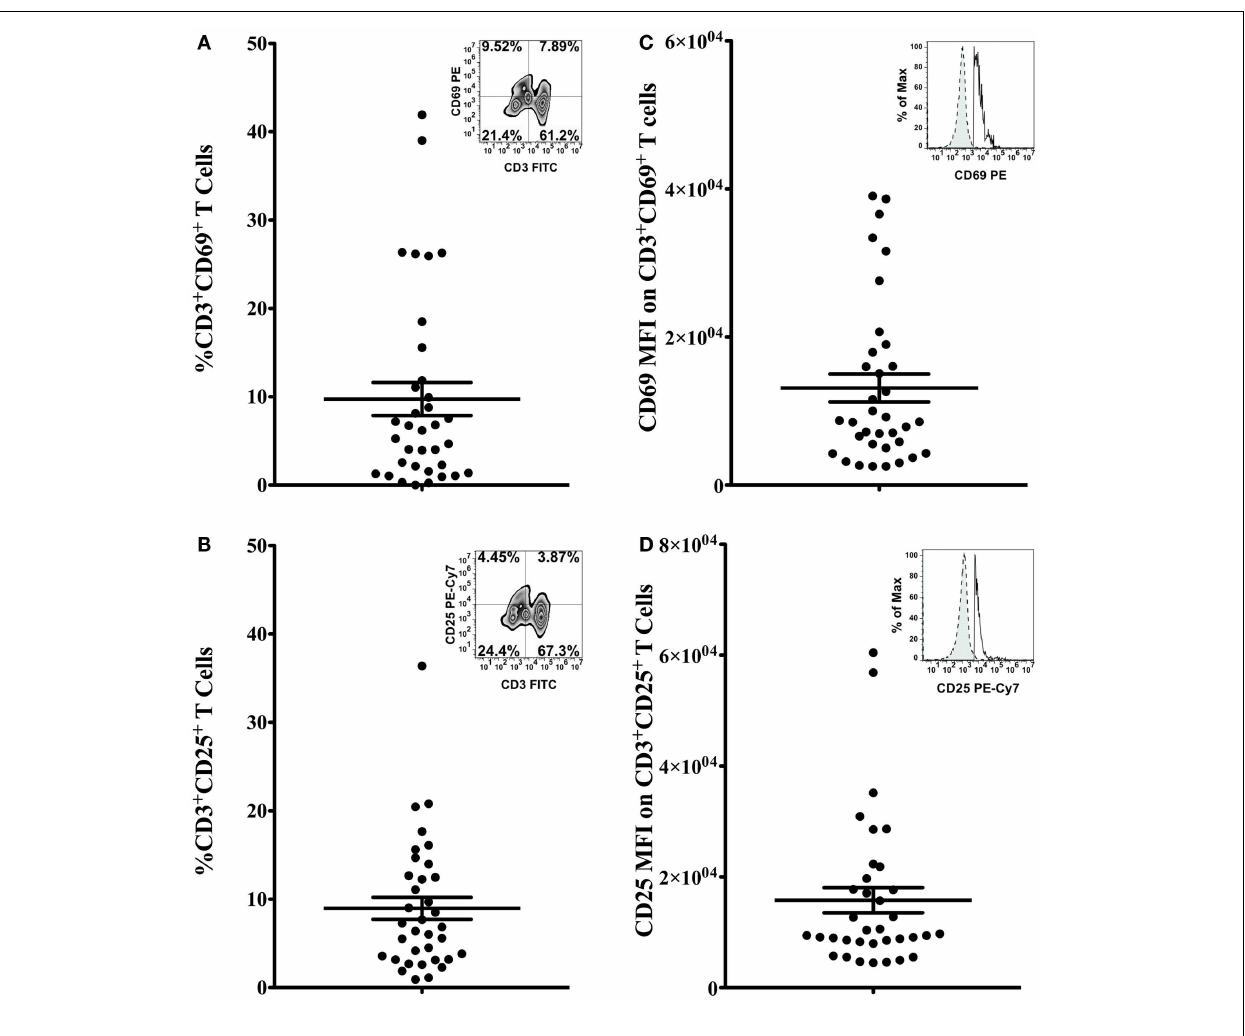
[ (A) inset] or CD25 expression [ (B) inset] from one representative subject are shown. Insets of (C,D) show flow histograms of CD69 MFI on CD3 + CD69 + T cells and CD25 MFI on CD3 + CD25 + cells from one representative subject. Dashed lines represent isotype controls and solid lines represent experimental